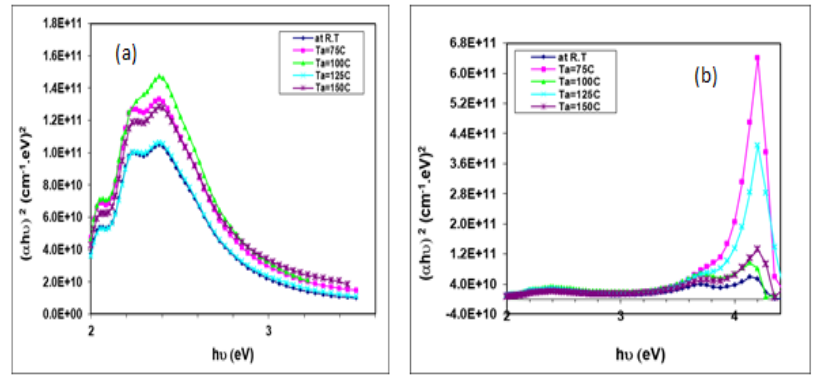
Fig.7: ( α hv) 2 versus photon energy (hv) of incident radiation for (a) P3HT and (b) P3HT:PC BM thin films at different annealing temperatures. 61 Table 3: The optical constants of P3HT and P3HT:PC annealing temperatures at λ =550